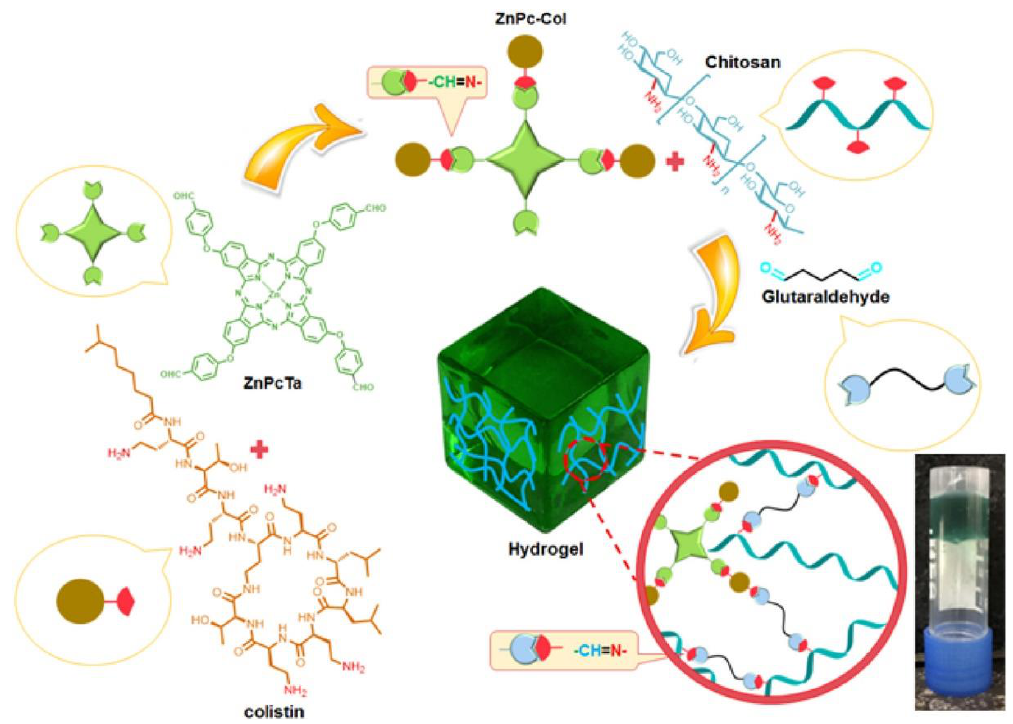
Figure 17. Schematic representation of the ZnPc–Col-containing hydrogel. Reprinted with permission. Copyright 2019, Elsevier [87].